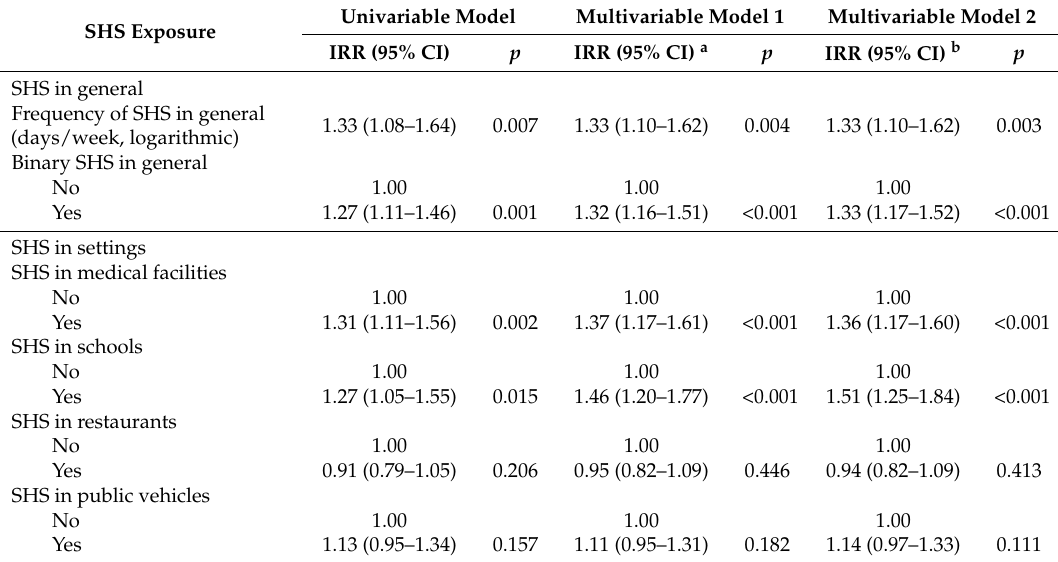
Table 2. Association between SHS exposure and depressive symptoms among non-smokers in Guangdong, China, 2010.